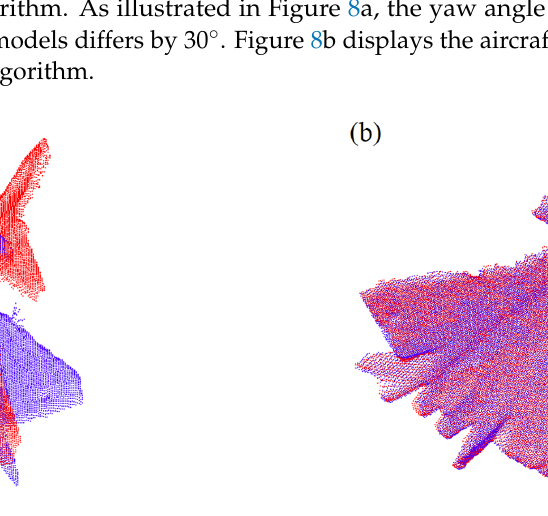
Figure 9. Hardware diagram of the measurement system.